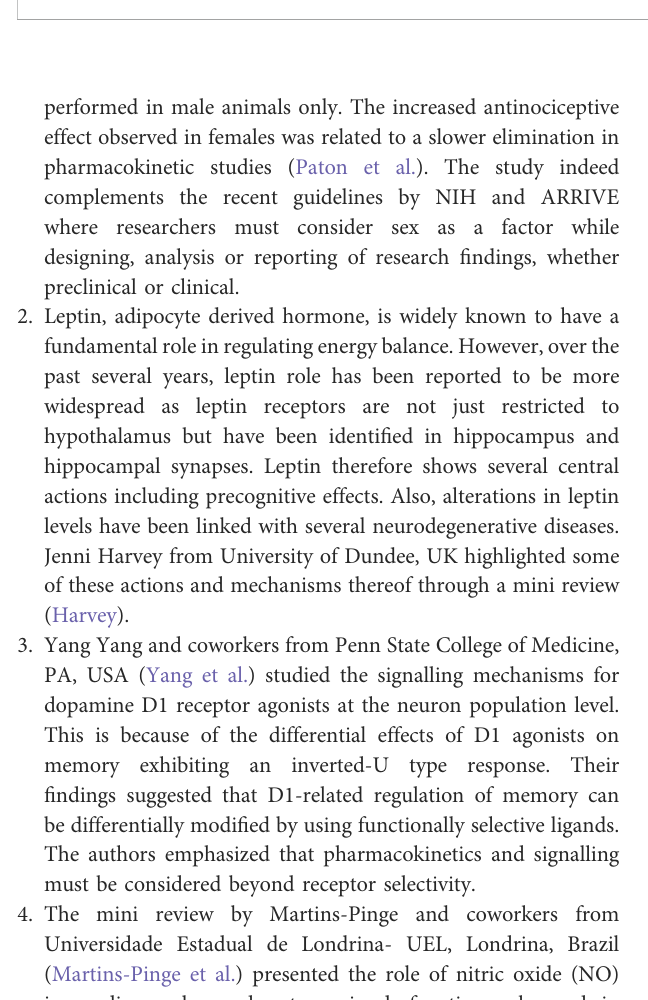
FIGURE 1 Highlights of articles from Women in Neuropharmacology 2021